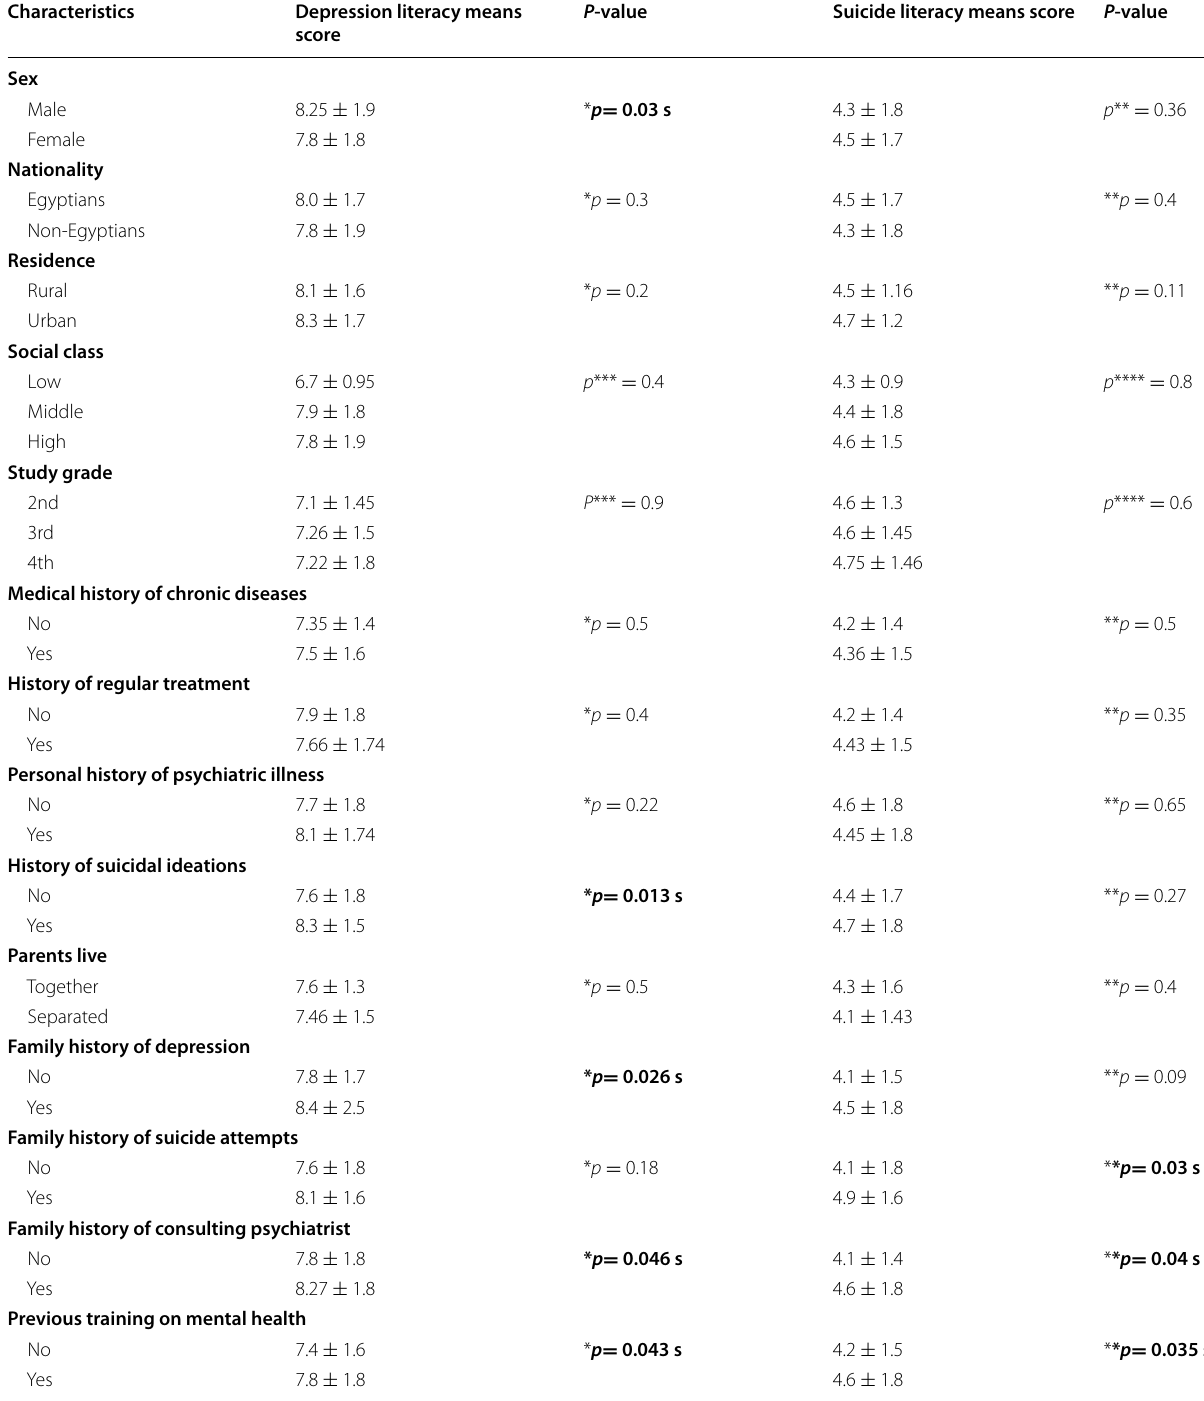
Table 5 Relation between studied medical students’ characteristics and depression and suicide literacy mean